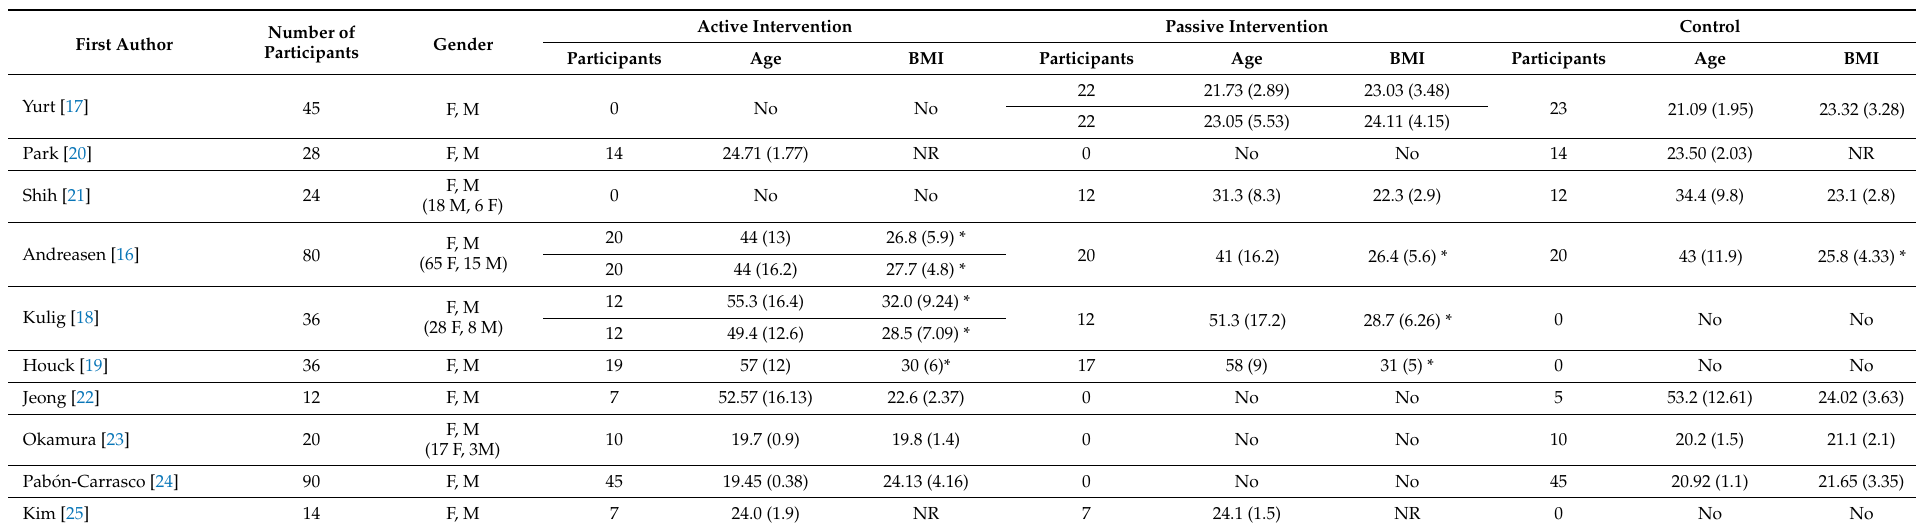
Table 1. Characteristics of selected